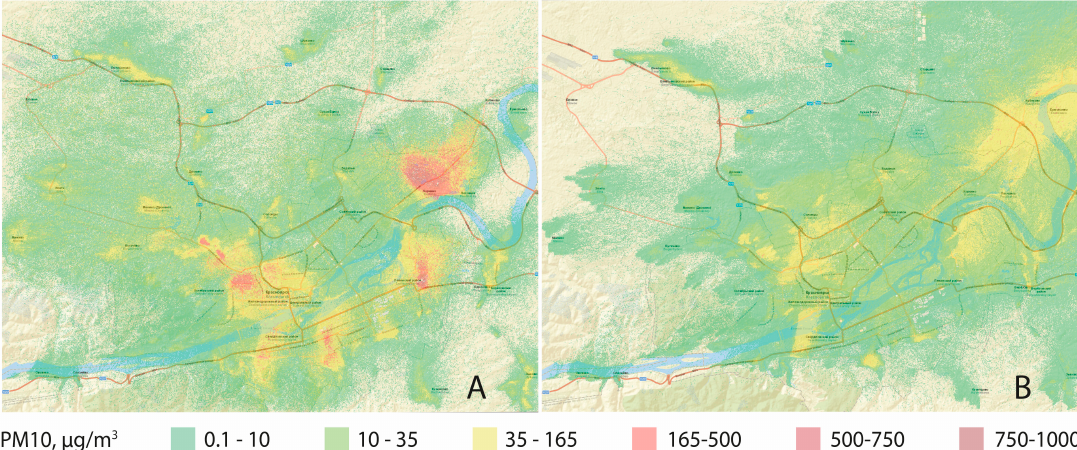
Figure 13. Spatial distribution of PM10 in the surface layer of Krasnoyarsk atmosphere (2 m above the ground) at the beginning ( A ) and the end ( B ) of AWC.